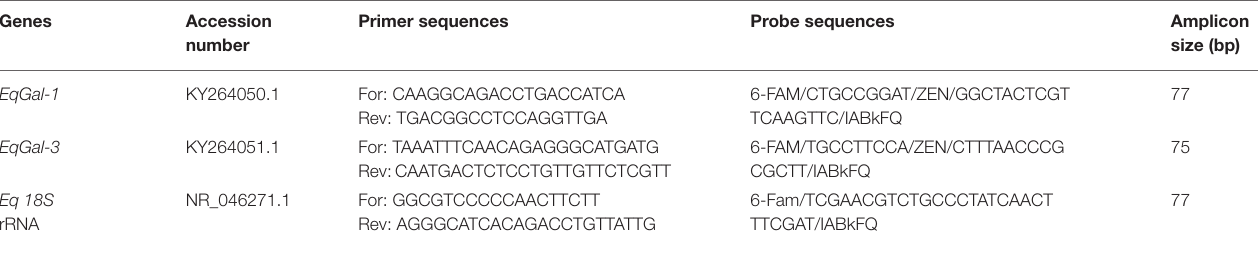
TABLE 1 | Genes, primers, and probes for TaqMan